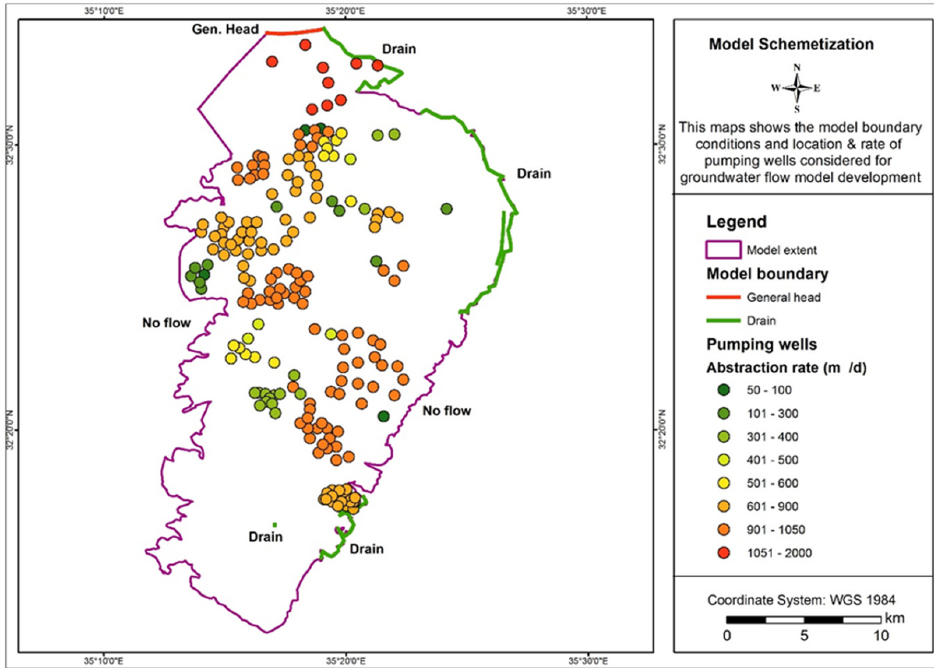
Figure 5. Boundaries and distribution and rates of wells, as used in the model.